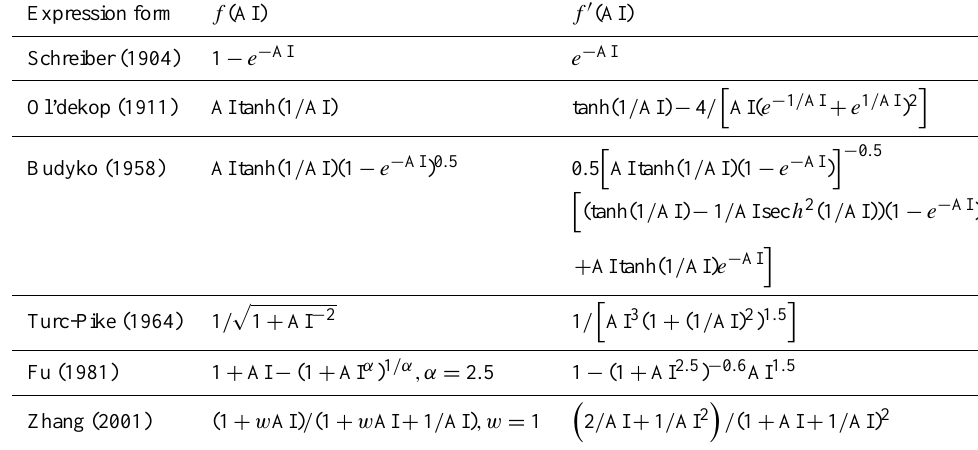
Table 1. The six commonly used forms of expressions and their first derivatives based on the Budyko framework. Expression